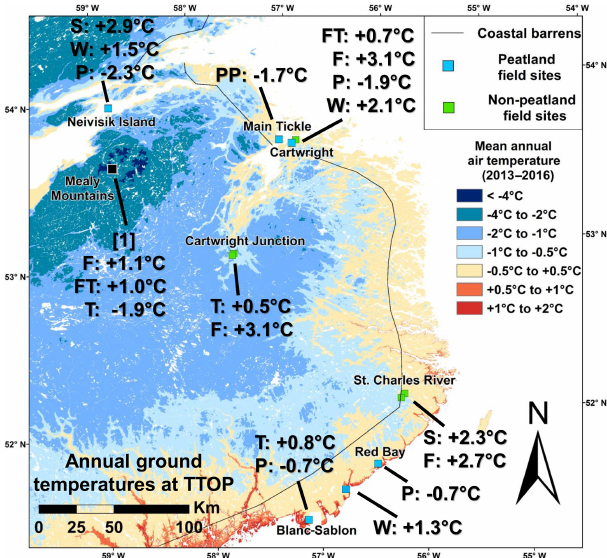
Figure 12. Average ground temperatures (2013–2016) at or close to the top of permafrost or the base of seasonal freezing at University of Ottawa monitoring locations in southeastern Labrador (Way and Lewkowicz, 2018) superimposed on a map of mean annual air tem- perature (2013–2016) (Way et al., 2017). Letters denote primary land cover class at each location: F – forest; P – palsa; PP – peat plateau; S – shrub; T – tundra; and W – wetland. At Cartwright, ground temperatures for palsas were averaged from three